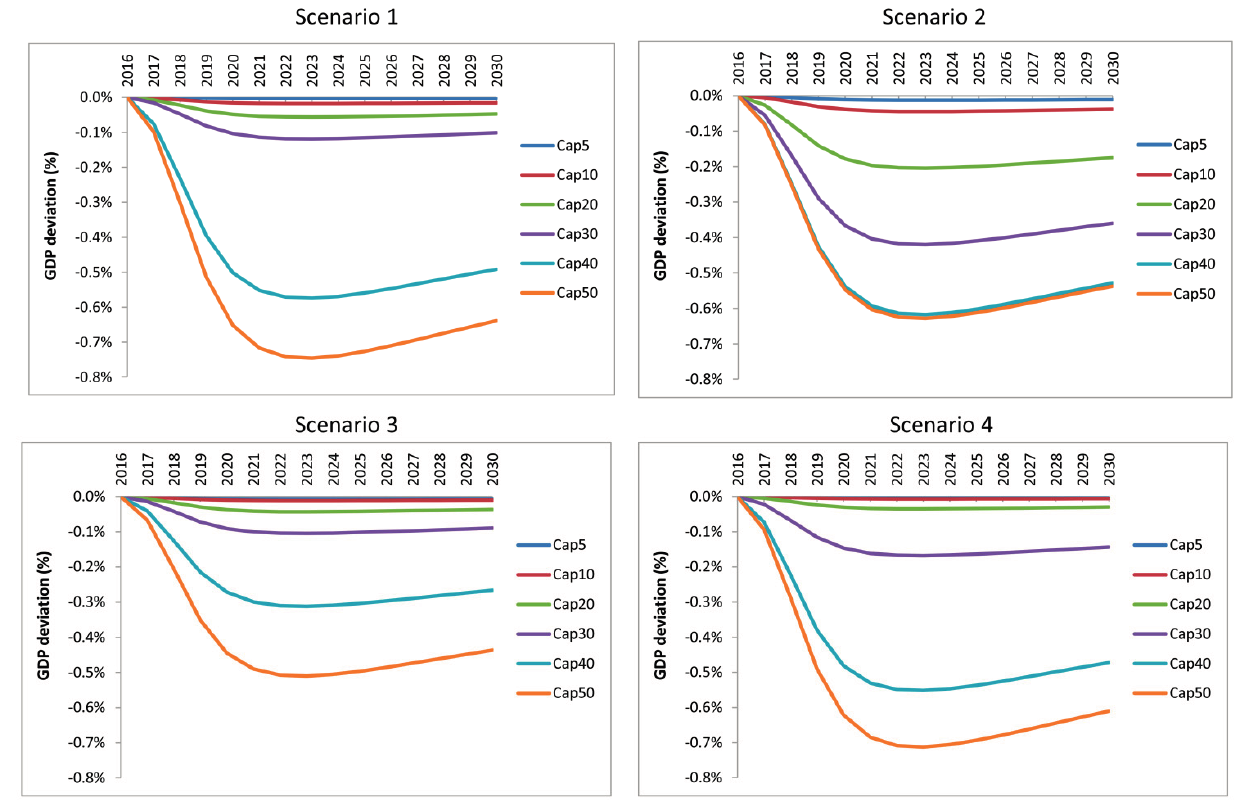
Figure 13. Effect of sectoral cap on the level of GDP (% over baseline